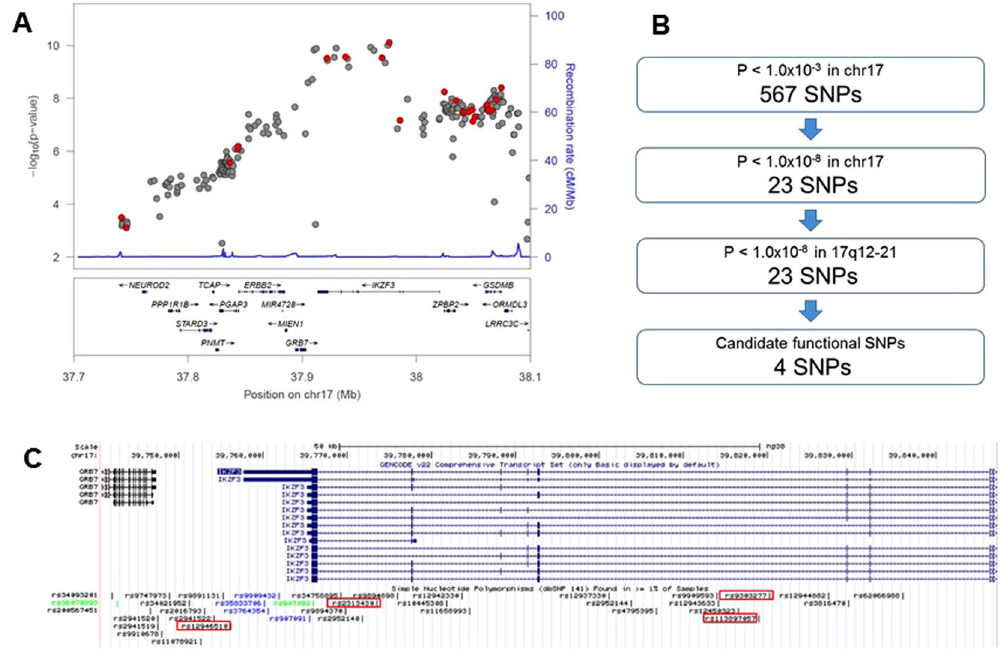
Figure 1. Selection of candidate functional variants in chr.17q12-21 that conferred susceptibility to PBC by using high-density association mapping. ( A ) Result of a high-density association mapping that was based on SNP imputation analysis using a whole-genome sequence reference panel of 1,070 Japanese individuals from a prospective, general population cohort study (1KJPN) and genotype data from our previous GWAS (PBC patients: n = 1,389; healthy controls: n = 1,508). The p-value of each SNP is indicated by a dot. Red dots show experimentally genotyped SNPs by GWAS. ( B ) Scheme of SNP selection based on in silico functional analysis. There were 567 and 23 SNPs whose P values were less than 1.0 × 10 − 3 and 1.0 × 10 − 8 , respectively, that were located in chromosome 17. The latter 23 SNPs in chromosome 17 are all located in chr.17q12-21. Of these 23 SNPs, 2 SNPs (rs9303277 and rs113897057), which showed the most significant associations with susceptibility to PBC, and the candidate primary functional variants (rs2313430 and rs12946510) were chosen. These SNPs are located in a transcription regulatory element as assessed by the presence of a DNase I hyper-sensitivity cluster or H3K27Ac marks, and/or their location in a region that might modulate transcription factor binding. ( C ) Positions of the four candidate functional variants in the chr.17q12-21 locus. Candidates are shown in the red